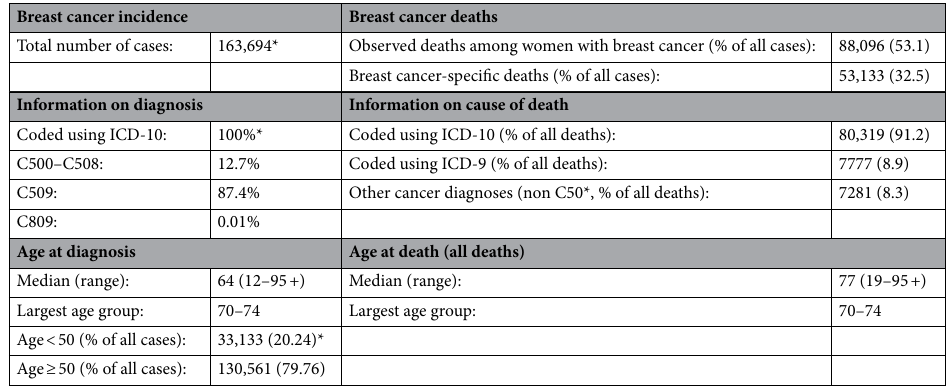
Table 1. Breast cancer incidence and deaths in women in Austria, Austrian Cancer Registry, 1983–2017. *Cases in underaged (< 18 years of age at the time of diagnosis) were excluded (n =